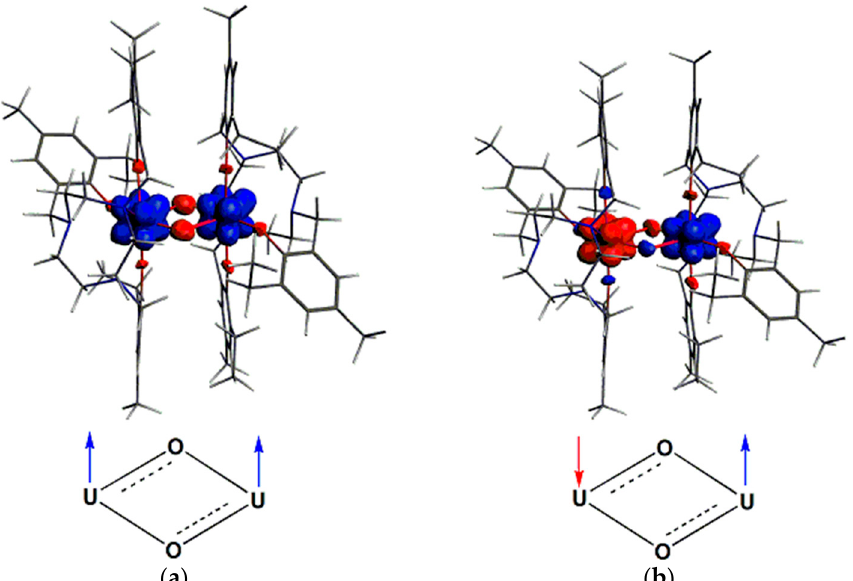
Figure 20. ZORA/B3LYP spin density surfaces for the HS (triplet) in left and BS states in right of U V ( µ -O) 2 U V complex (blue color: positive and red color: negative spin density). The plotted isodensity surfaces ( a ) HS and ( b ) BS states corresponds to a value of ± 0.0025 e bohr –3 . (reprinted with permission from [155], American Chemical Society,